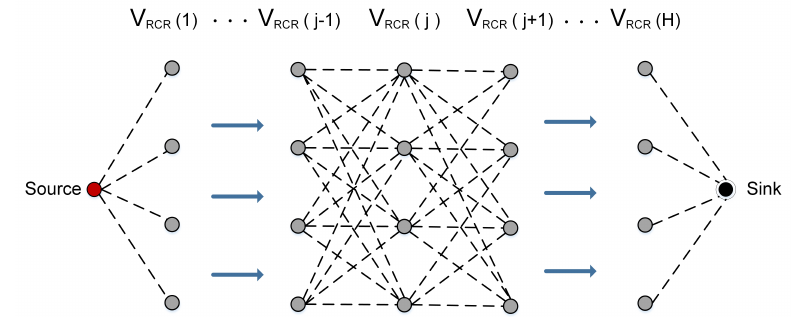
Figure 2. Cooperation between adjacent groups of cooperative